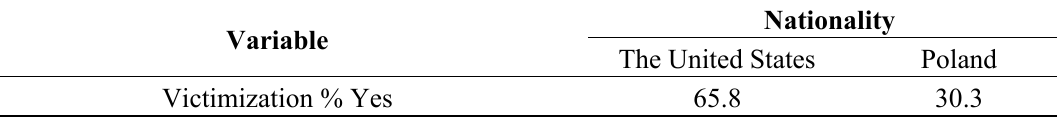
Table 2. Cross-tabulations of nationality and socially interactive intimate violence (N =